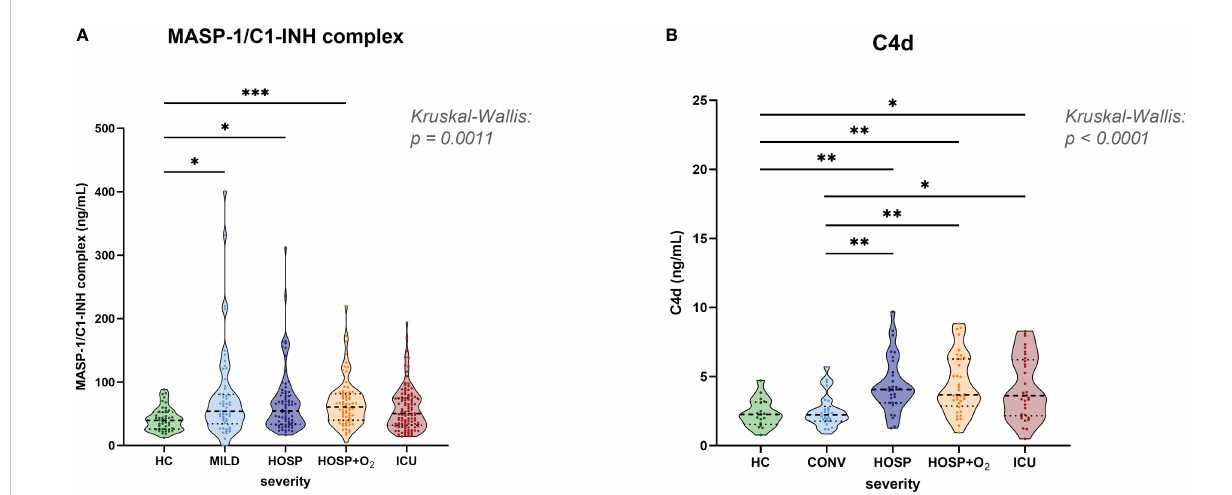
FIGURE 3 Levels of lectin pathway activation products in healthy controls and COVID-19 patients. (A) MASP-1/C1-INH complex and (B) C4d levels were measured in EDTA plasma samples and strati fi ed according to severity in healthy controls and the merged COVID-19 cohort. Differences between severity groups were determined using Kruskal-Wallis test with Dunn ’ s multiple comparison post-hoc test. Non-signi fi cant differences are not marked, and asterisks indicate signi fi cant results (* p<0.05, ** p<0.01, *** p<0.001). HC, Healthy controls; MILD, patients not requiring hospitalization; CONV, patients not requiring hospitalization and sampled during convalescence; HOSP, Hospitalized patients not requiring ventilation; HOSP+O 2 , Hospitalized patients requiring ventilation; ICU, Intensive care unit